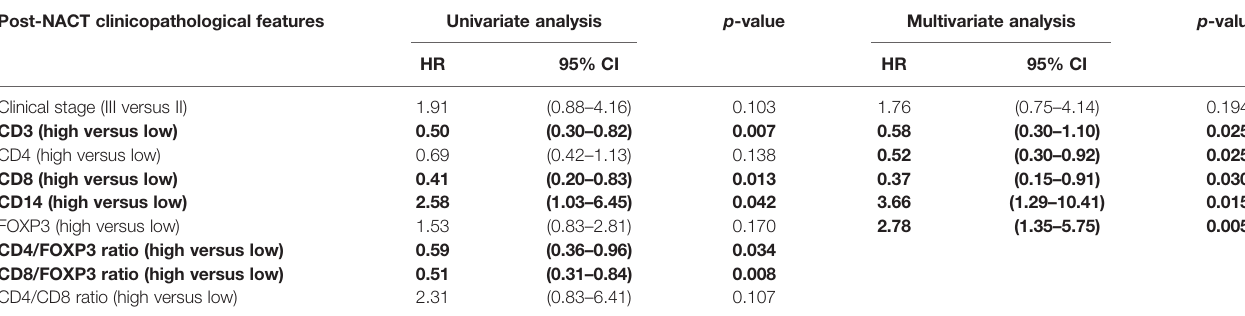
TABLE 2 | Post-NACT clinicopathological features and crude and adjusted hazards ratios for event-free survival (EFS) estimated by univariate analysis and multivariate